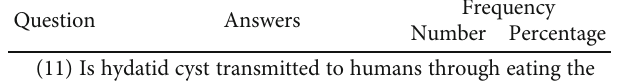
Table 2: Questionnaire items and responses regarding KAP among participants with a history of hydatid cyst surgery.